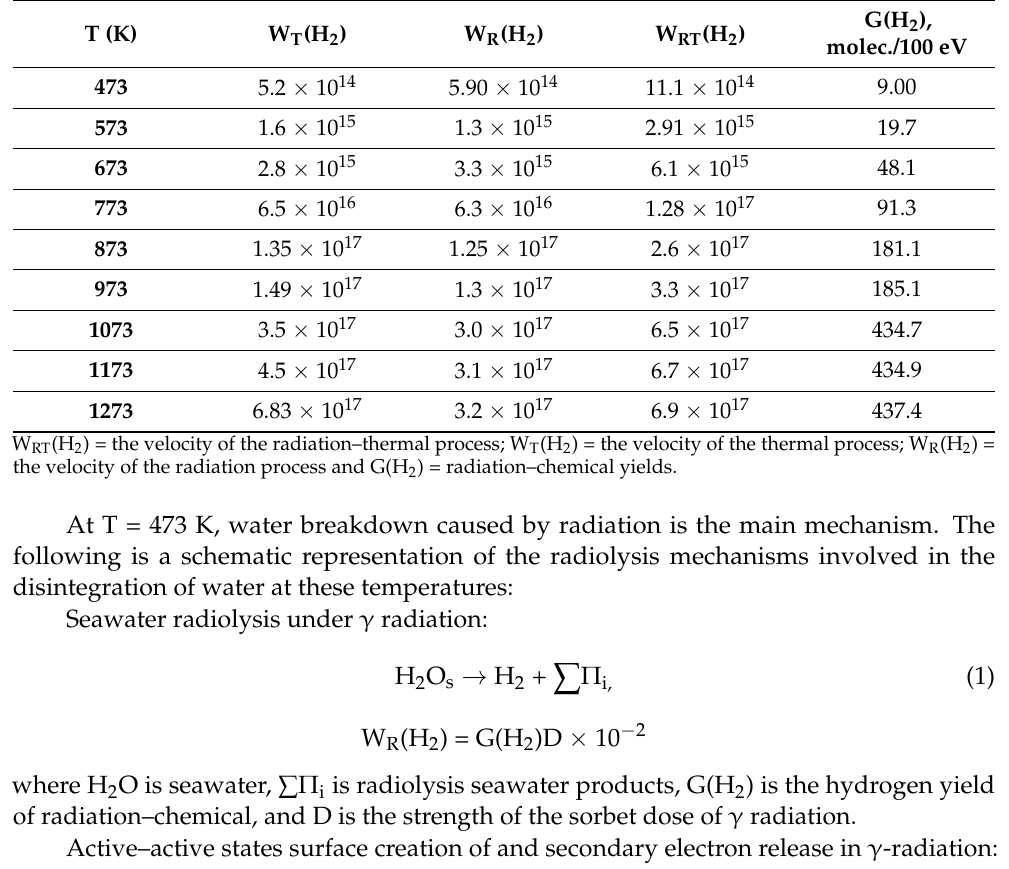
Table 2. The results of thermal, radiation, and radiation–thermal procedures and radiation–chemical yields of hydrogen in seawater decomposition with Zr1%Nb